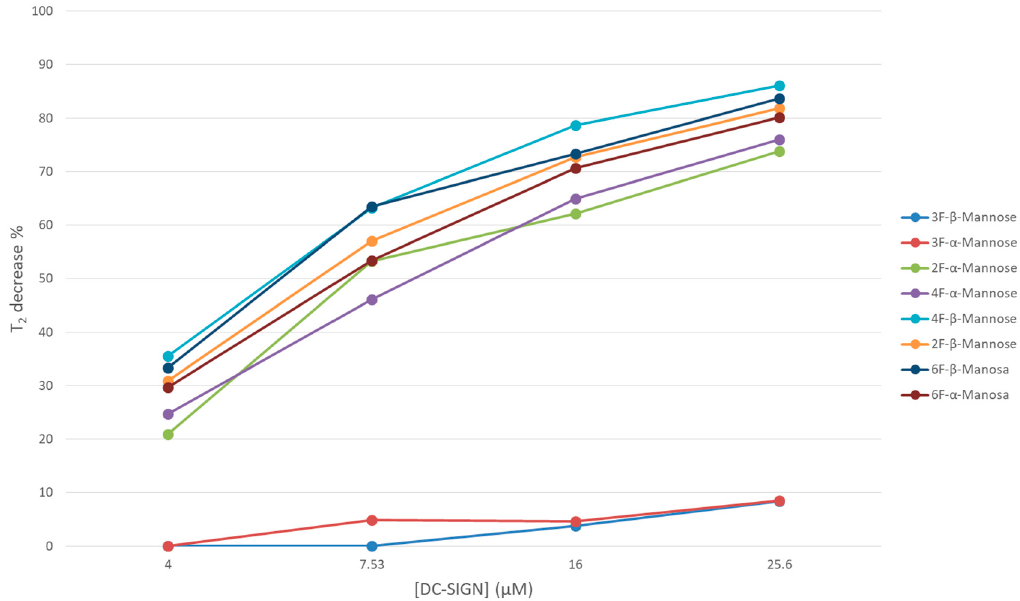
Figure 4. Percentage of decrease of the T 2 values for different ligand/lectin molar ratios deduced for the fluorine-containing Man moieties, as obtained from the 19 F-NMR relaxation filter experiments.